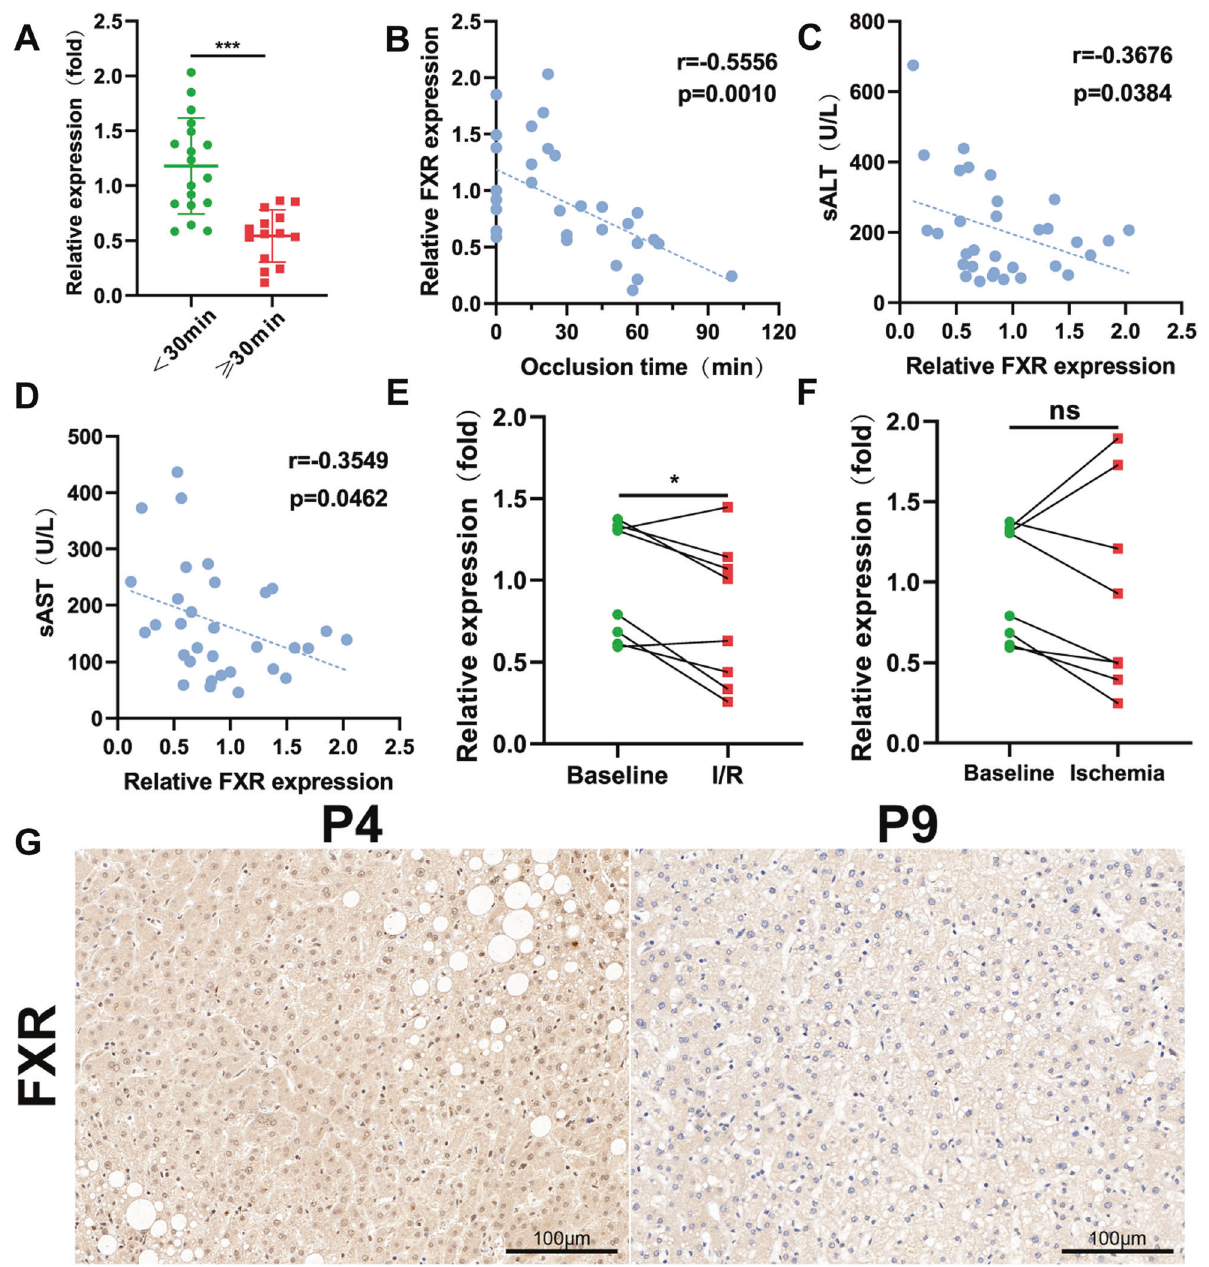
Fig. 7 Liver FXR levels are inversely correlated with liver damage. A The expression of hepatic FXR at the mRNA level in clinical samples with different occlusion times. Data are the mean ± SEM, ∗∗ p < 0.01. B Pearson correlation analysis between relative FXR expression and occlusion times. C , D Pearson correlation analysis between relative FXR expression and sALT or sAST. E , F Relative FXR expression in the sham and IRI or ischemia groups in a GEO dataset (GSE12720). G Representative FXR staining of clinical liver sections. Scale bars, 100 μ m. Schematic illustrating the possible mechanisms of the protective role of Abx pretreatment in hepatic